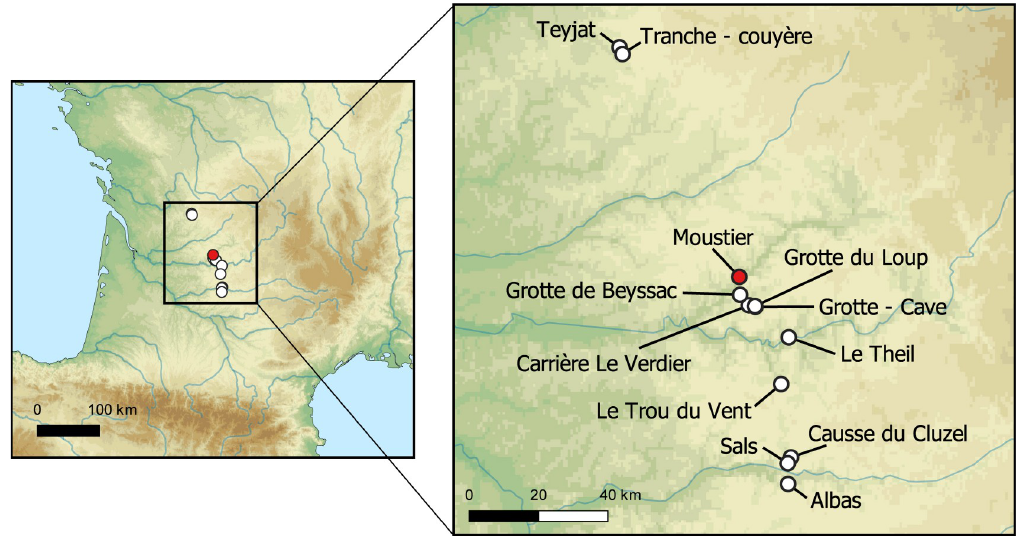
Fig 1. Location of Le Moustier and potential geological sources analysed in this study. Red triangle: Le Moustier; white circles: Mn-rich outcrops. Background map generated using GEBCO https://www.gebco.net and Natural Earth https://www. naturalearthdata.com